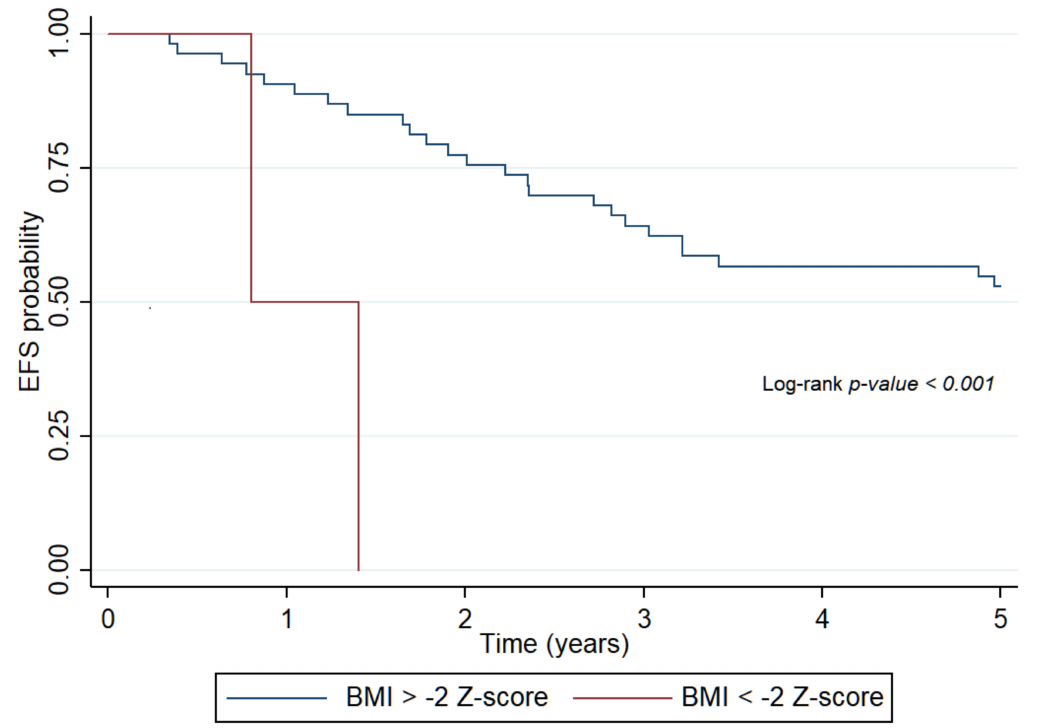
Figure 3. Probability of event-free survival of patients with solid tumors determined by body mass index Z-score at the end of treatment. EFS: event-free survival, BMI: body mass